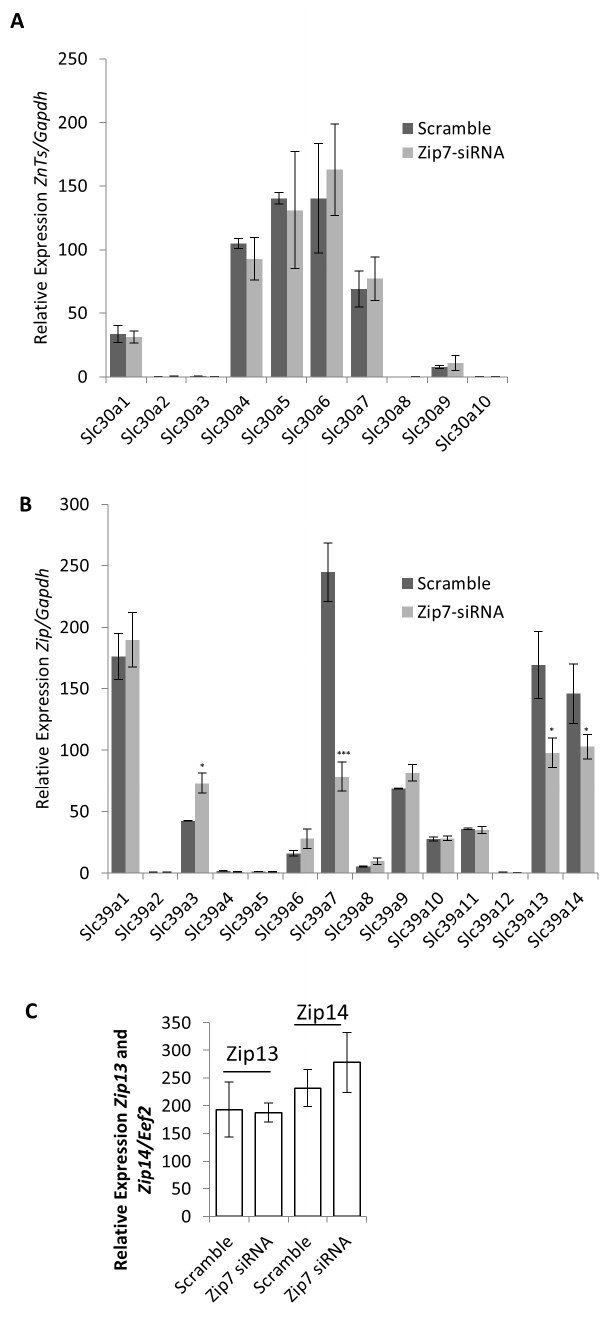
Figure 4. Reduced Zip7 expression has minimal influence on the expression of other zinc transporter genes. A). Relative expression of the ZnT s ( Slc30a1-10 ) to Gapdh in the scramble control versus the siRNA- Zip7 . B). Relative expression of the Zip s ( Slc39a1-14 ) to Gapdh in the scramble control versus the siRNA- Zip7 . C and D). Relative expression of Zip13 and Zip14 , respectively in the siRNA- Zip7 cells. Error bars indicated the 6 SD from three independent biological samples. * P , 0.05, *** P ,